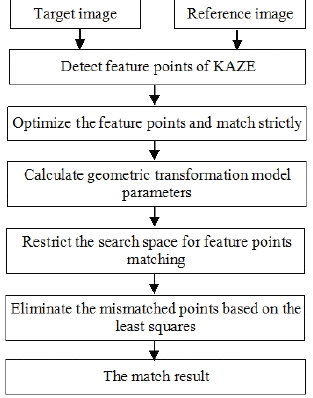
Figure 1. The flow char of the proposed